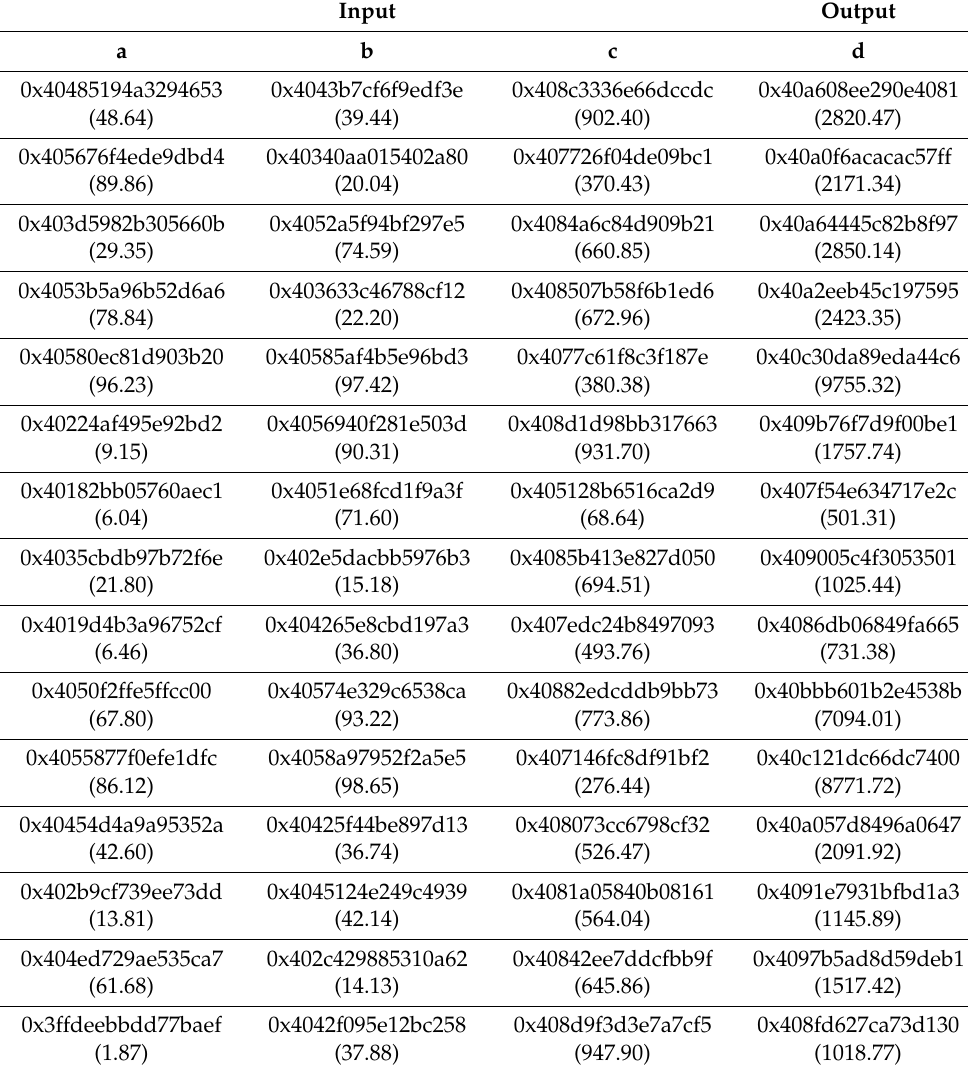
Table 2. Sample 2 results of DCIM-FF